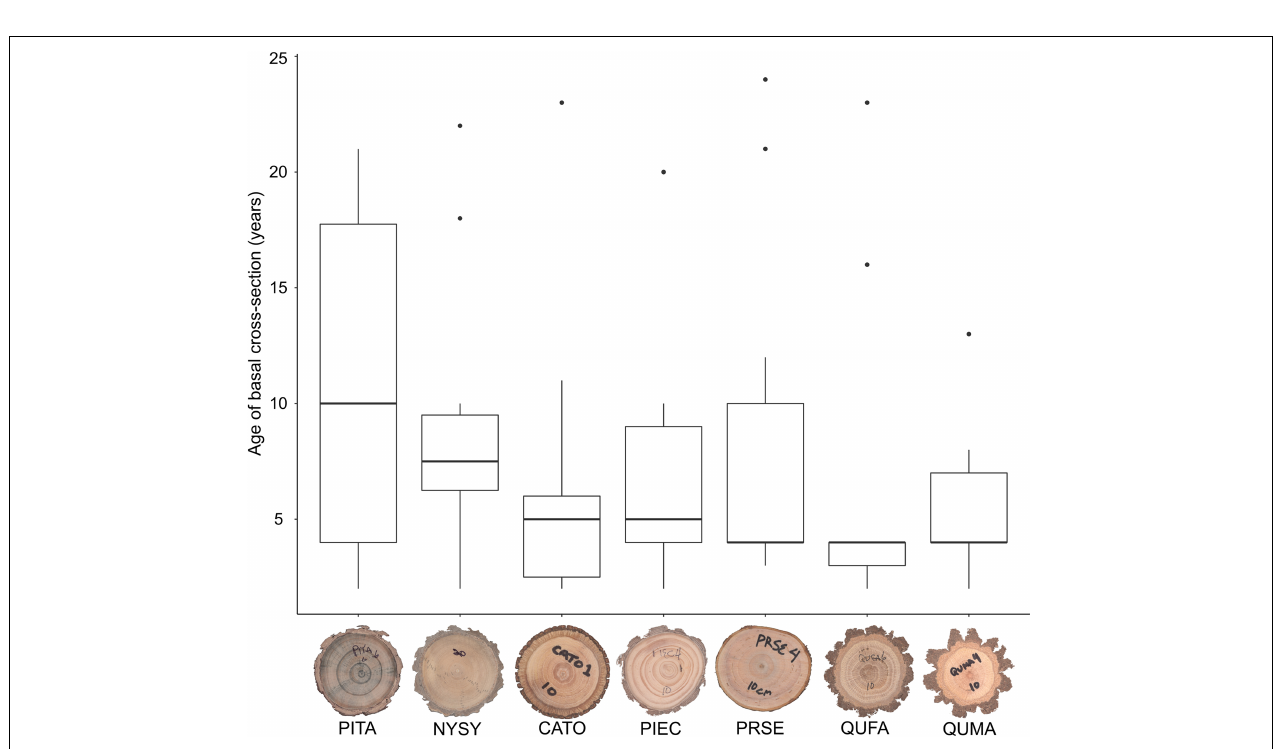
FIGURE 4 | Age of basal cross-sections in seven co-occurring tree species. Species codes are as follows: QUMA, Quercus marilandica ; QUFA, Quercus falcata ; PIEC, Pinus echinata ; PITA, Pinus taeda ; NYSY, Nyssa sylvatica ; CATO, Carya tomentosa ; PRSE, Prunus serotina . Horizontal bar in each boxplot represents the median